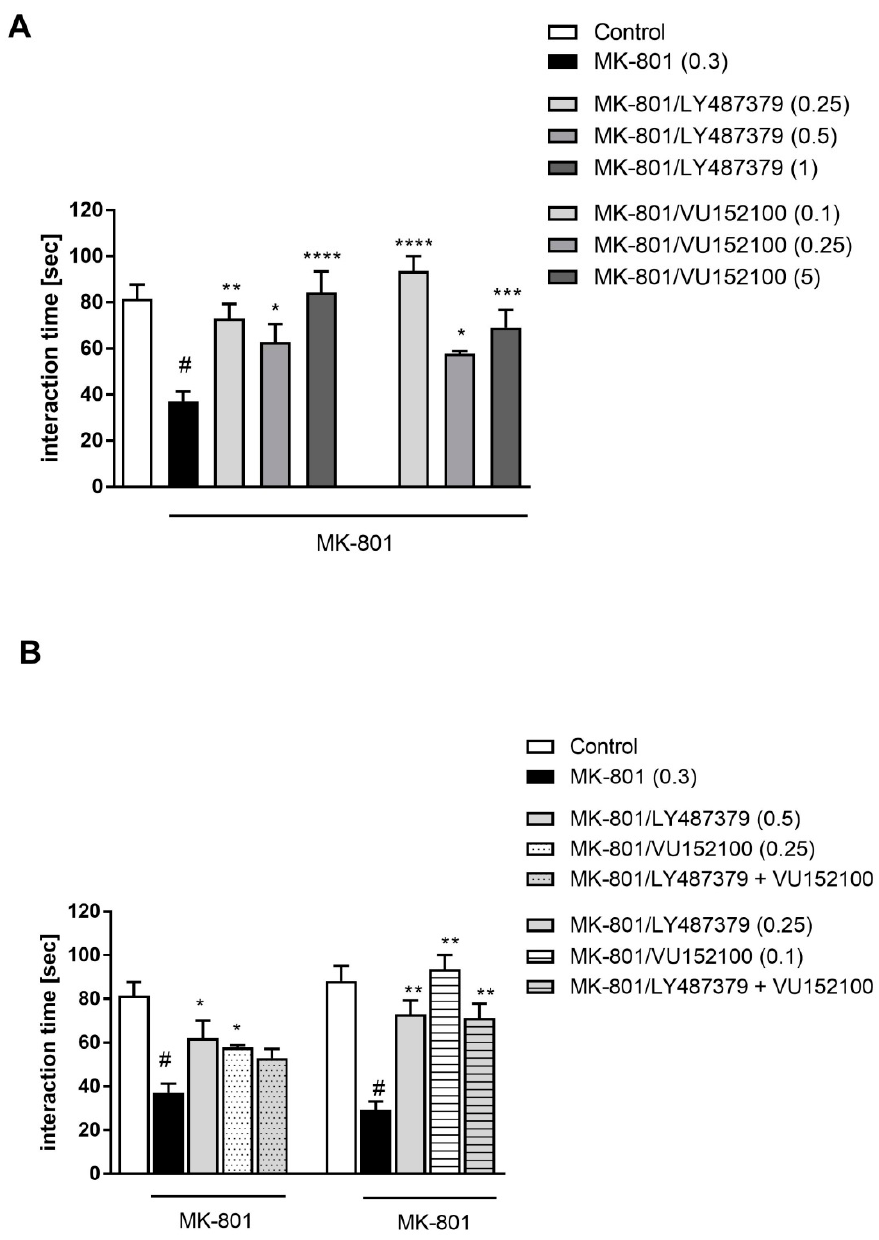
Figure 7. Social interaction test in mice after chronic administration (7 days) of MK-801. Effectivity of LY487379 and VU152100 administered alone ( A ), and combined administration of low doses of LY487379 and VU152100 ( B ) to treat MK-801-induced dysfunctions. Compounds were administered acutely 30 min before the test. Investigated doses are indicated in parentheses. Bars represent the means ± SEM. N = 8–10 pairs/group. # p < 0.001 versus the control group; * p < 0.05, ** p < 0.01, *** p < 0.001 and **** p < 0.0001 versus the MK-801-treated group.